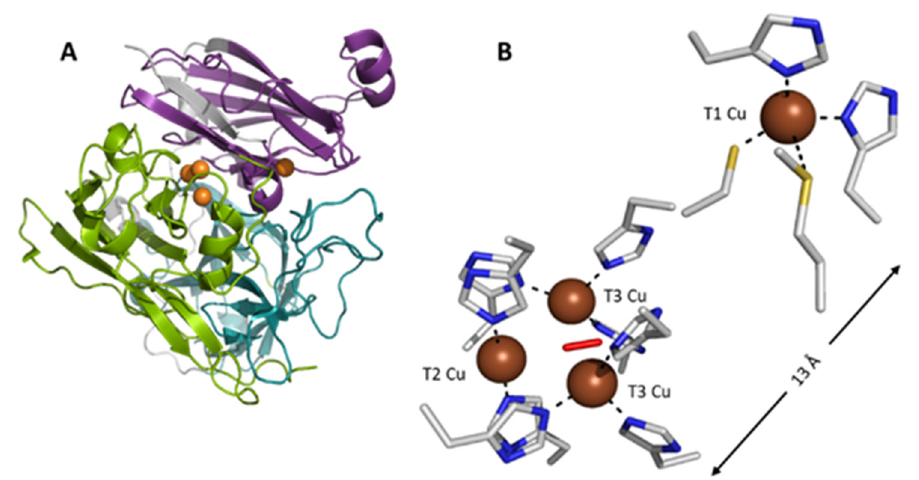
Figure 1. ( A ) Representation of the three-dimensional structure of CotA laccase with the cupredoxin domains coloured differently (residues 1–173, domain1: green; residues 182–340, domain2: blue; residues 369–501, domain 3: violet). The four copper atoms are shown as orange spheres. ( B ) The mononuclear T1 centre is on the right and the trinuclear centre is on the left. Pictures drawn with the use of PyMOL software and supported by the deposited structure in Protein Database PDB1w6l.